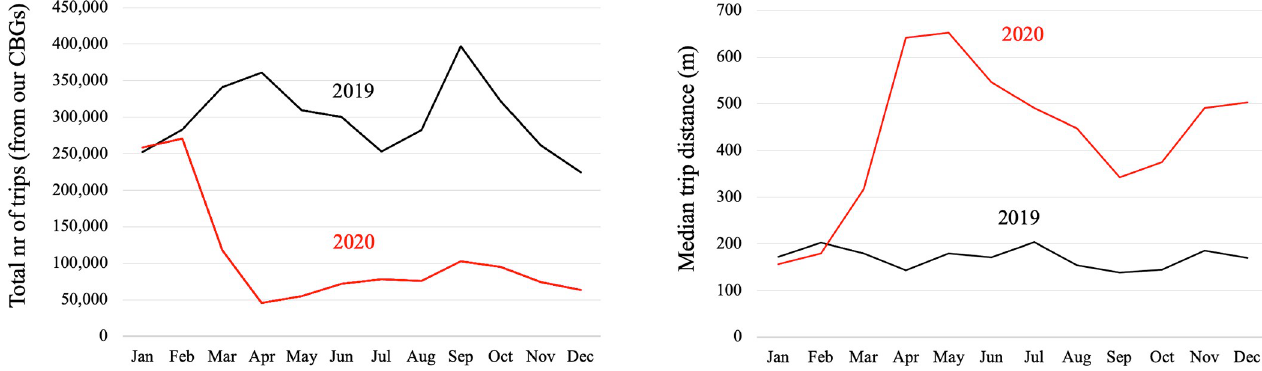
Fig 4. 2020 changes in observed amenity-oriented trip volumes (left) and median trip distances (right) from CBGs in our study area, as compared to 2019. Note: We observe trips from the CBG centroid to particular establishments in a cluster (rather than the cluster centroid), and compute the median distance from a CBG centroid to a